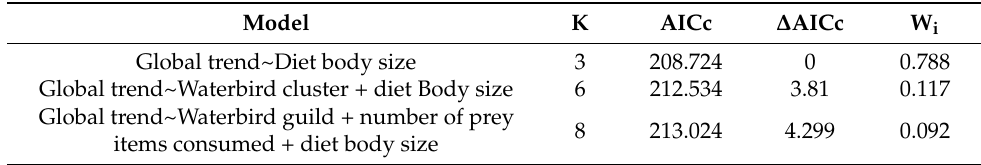
Table A2. Results of the Akaike information criteria for the top candidate models used to model the global population trends of waterbirds in southern